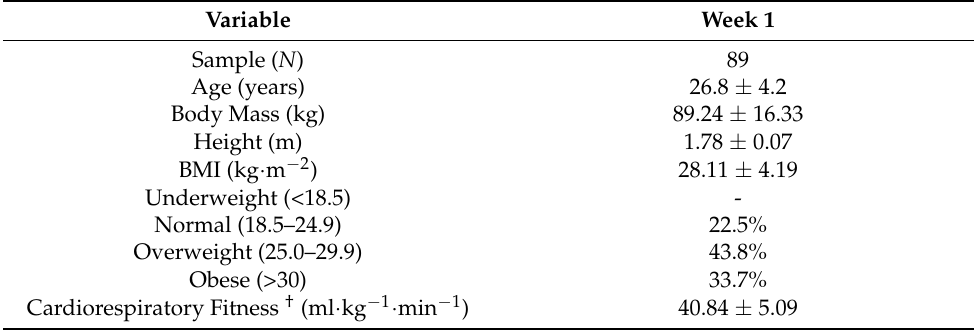
Table 1. Participant Descriptive and Fitness Statistics at Weeks